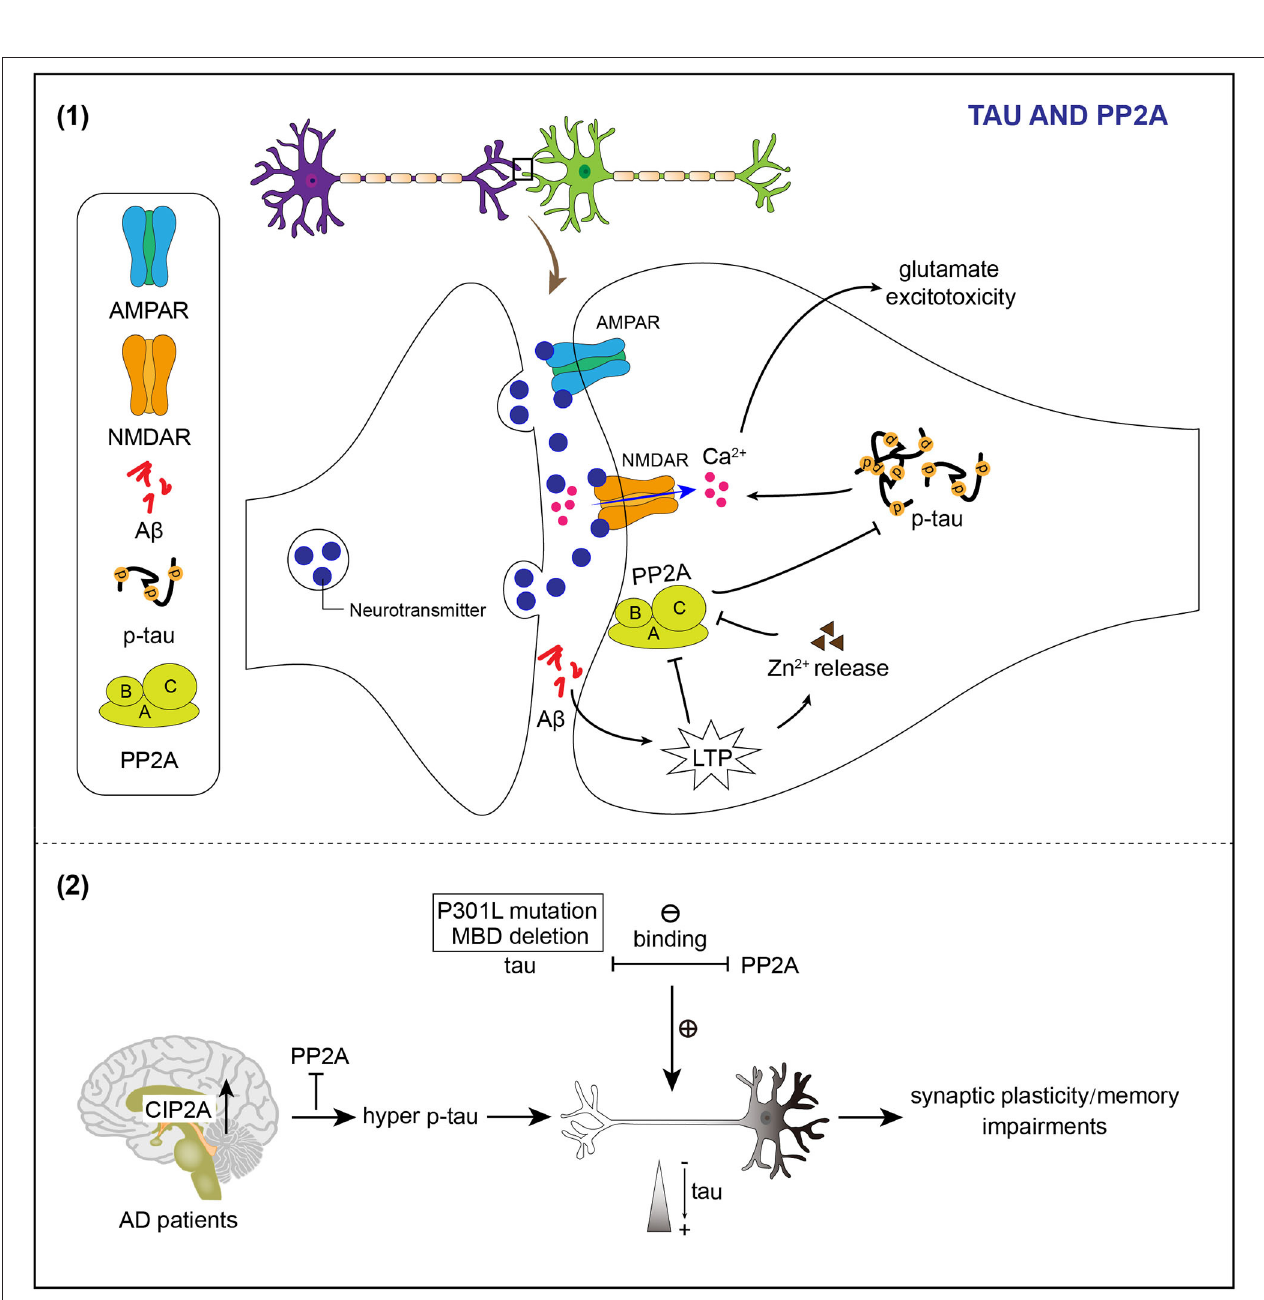
FIGURE 1 | of N-Methyl-D-Apartate receptors (NMDARs) by tau. Phosphorylation of tau promotes the tau-Fyn binding and meanwhile weakens the interaction between tau/Fyn and PSD-95/GluNR2B. (2) The intermediation of A β oligomer between tau and Fyn. A β oligomer enhances the interaction between tau and Fyn and leads to the dendrite spine translocation of tau in a Fyn-dependent manner. A β oligomer also simulates the Fyn/ERK/S6 pathway to enable de novo protein synthesis of tau in the somatodendritic domain.